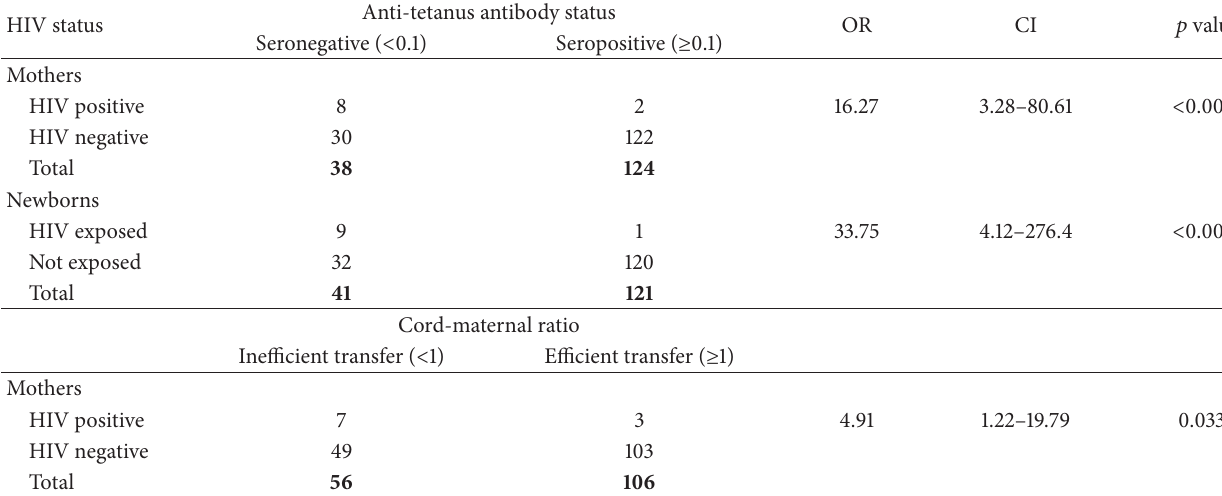
Table 4: The effect of HIV infection on maternal and newborn anti-tetanus antibody status and cord-maternal ratio (CMR). HIV